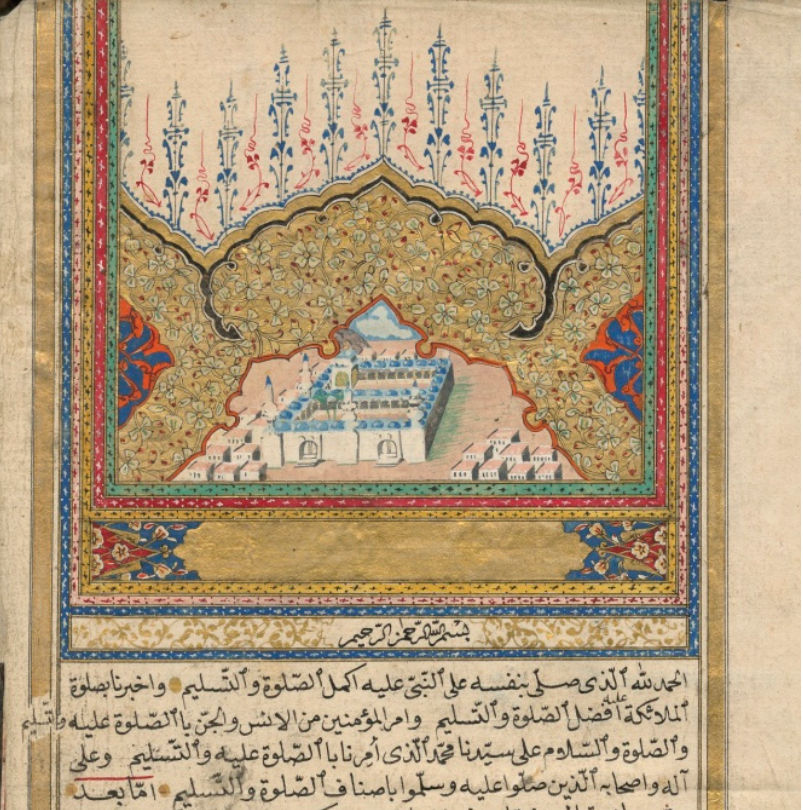
Figure 9. A miniature rendering of Medina surmounts the ‘ unw ā n (illustrated headspiece) at the beginning of this Ottoman Turkish translation and expansion of al-F ā s ī ’s commentary on the Dal ā ’il .